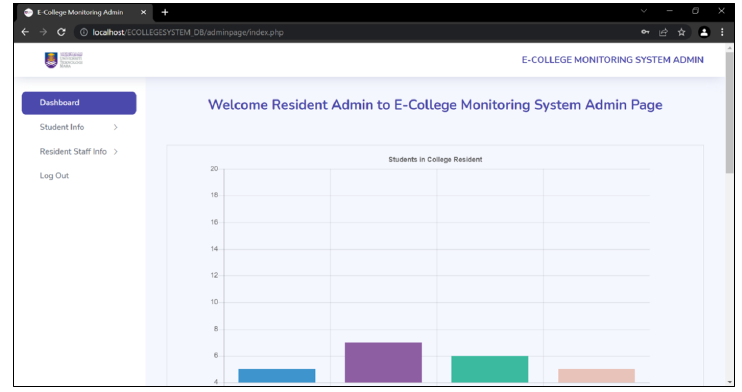
Figure 9. Students’ information page for the College Resident Staff (CSR). 5. Conclusions The E-College Monitoring System will provide students and resident staff with nu- merous benefits. The usage of technology can help to strengthen and secure the systems.